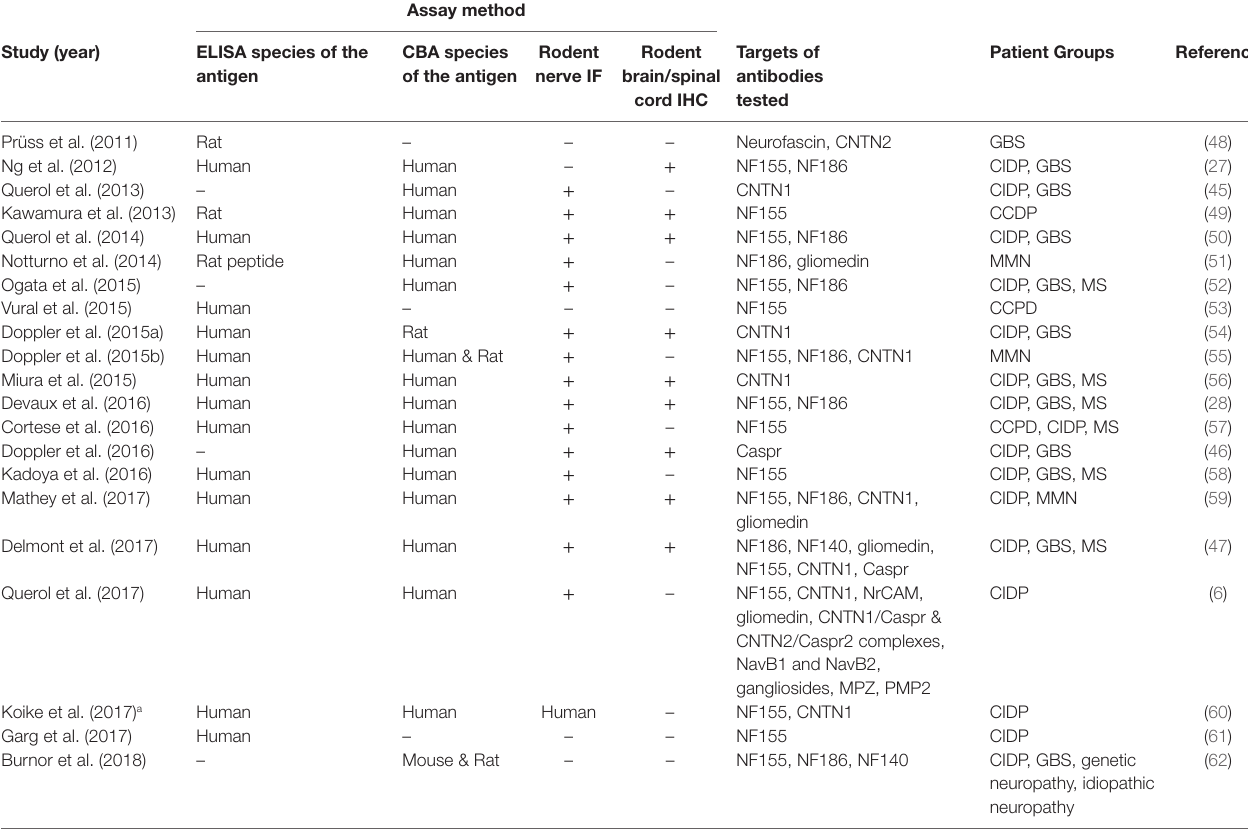
TABLe 1 | Methodologies and disease groups of the previous studies testing antibodies against nodal proteins in chronic inflammatory demyelinating polyneuropathy (CIDP) and peripheral